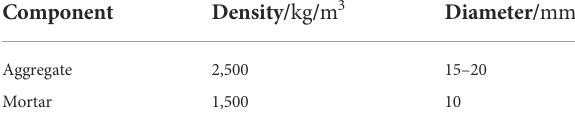
TABLE 1 Particle parameter